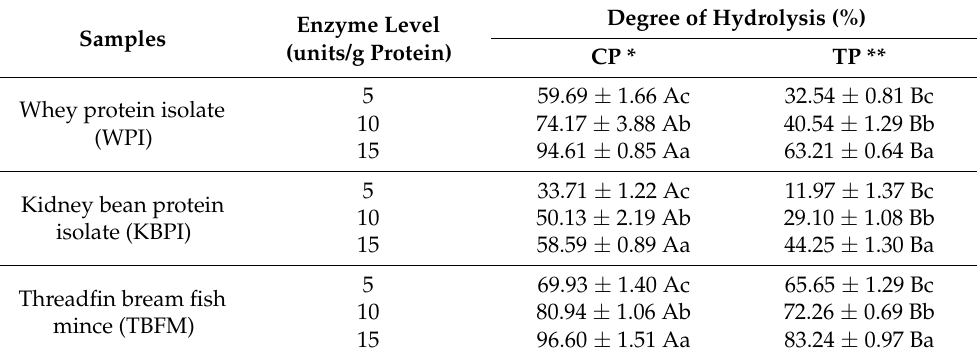
Table 2. Degree of hydrolysis of whey protein isolate, kidney bean protein isolate, and threadfin bream fish mince using commercial pepsin and crude tuna pepsin powder containing 10% maltodextrin and 5% trehalose at different